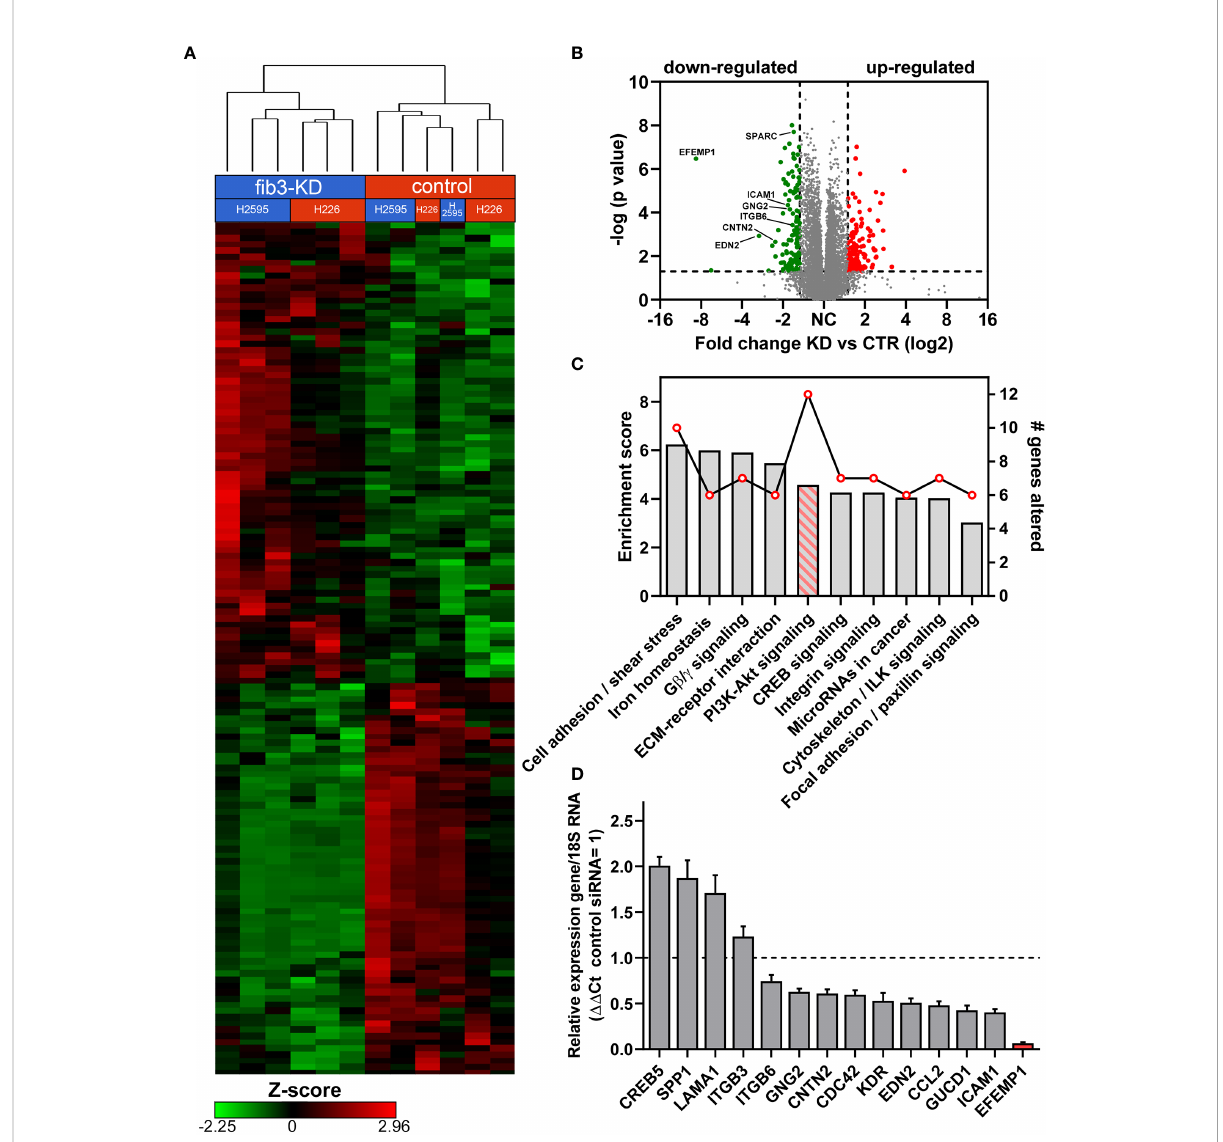
FIGURE 3 Fibulin-3 expression correlates with an enhanced cell-adhesion and PI3K signaling signature. (A) Gene expression clustering in two MPM cell lines after transient fi bulin-3 knockdown ( fi b3-KD ). Unsupervised cluster analysis revealed common genes downregulated in both cell lines. (B) Volcano plot of down- and up-regulated genes common to H2595 and H226 cells after fi bulin-3 knockdown; several cell-adhesion molecules are indicated among the down-regulated genes. (C) Pathway-enrichment analysis revealed top enrichment scores (bars) for cell adhesion mechanisms. The line indicates the number of genes altered for each of those pathways after fi bulin-3 knockdown, being highest for PI3K/Akt signaling. (D) Analysis of cell cell-adhesion genes in H2595 by qRT-PCR con fi rmed the downregulation of several of those genes after fi bulin-3 knockdown ( EFEMP1 is the of fi cial symbol of fi bulin-3